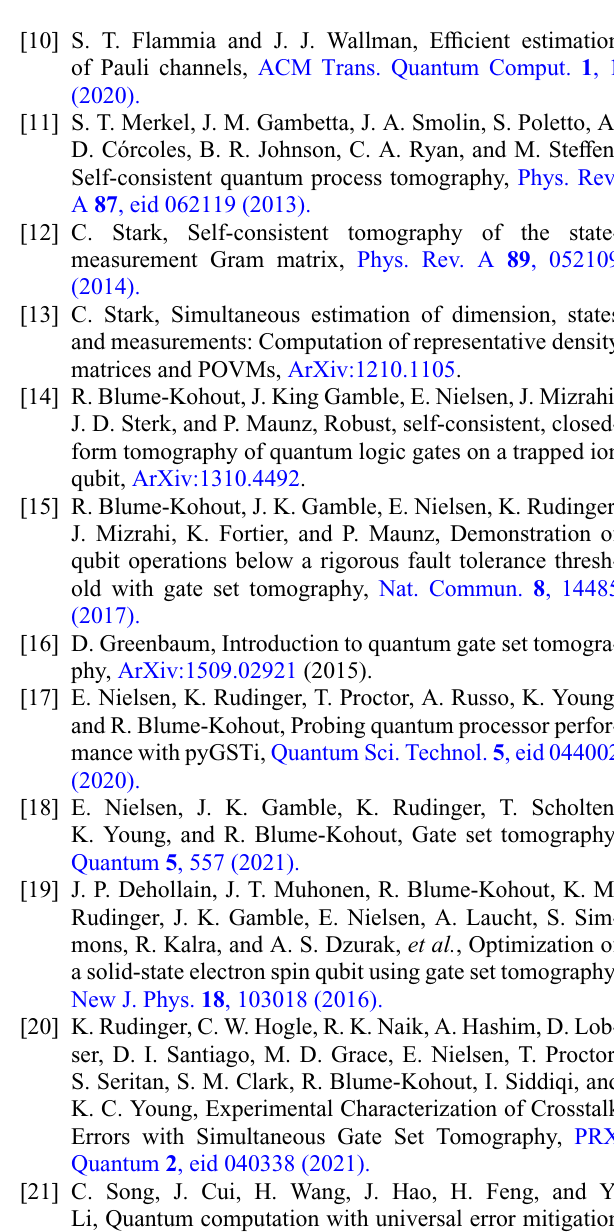
Protocol 1. GST-mitigated shadow